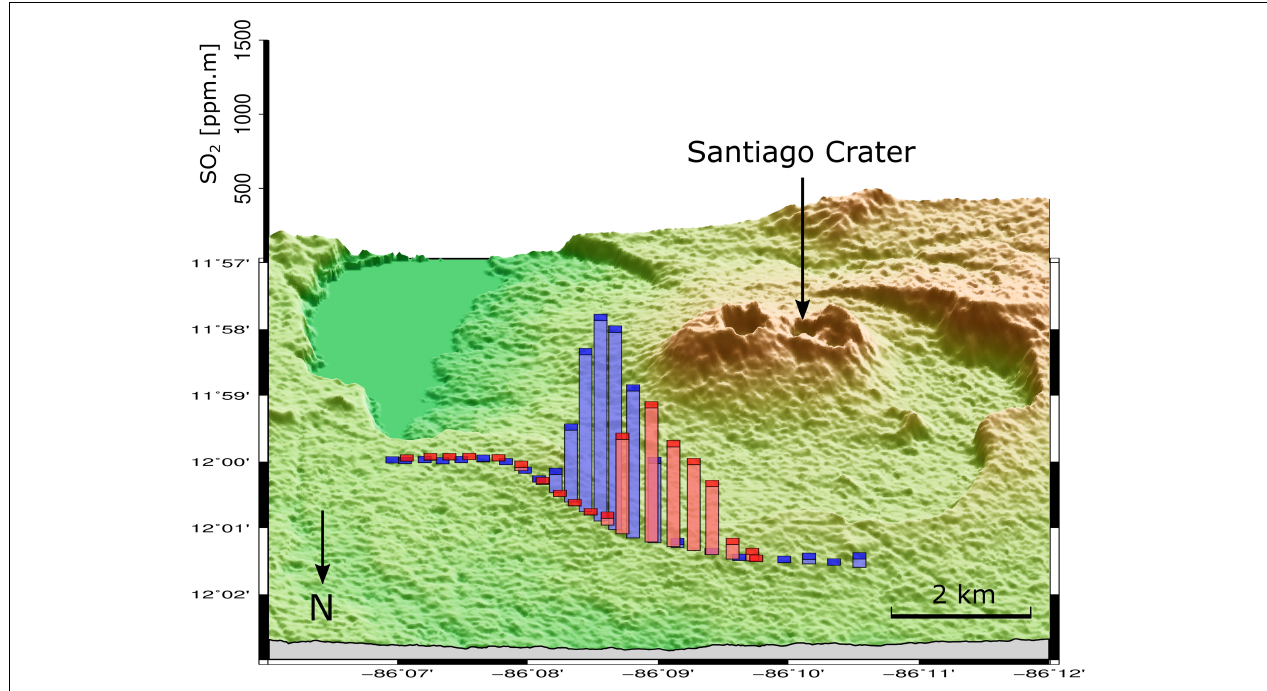
FIGURE 1 | Traverse SO 2 column densities (ppm · m) plotted in bars for two traverses started at 17:46:01 UTC (red) and 17:55:10 UTC (blue); emission rates were 16.3 and 27.2 kg s − 1 , respectively. Traverses were performed along La Carretera a Masaya. Base map topographic data retrieved from USGS (2018). Data for this figure, and all other figures in this manuscript, are available in Supplementary Data Sheet S1